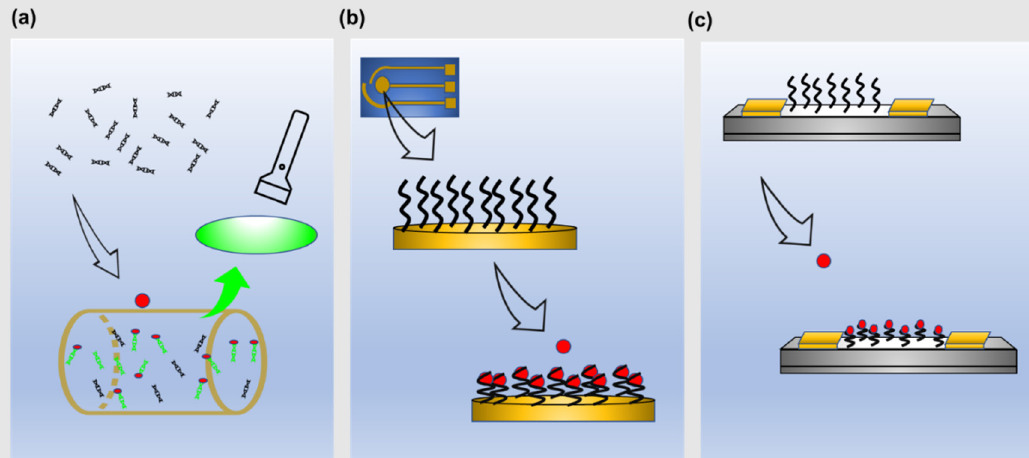
Figure 4. Schematic illustration of various transduction mechanisms, i.e., ( a ) optical, ( b ) electrochemical, and ( c ) electrical.